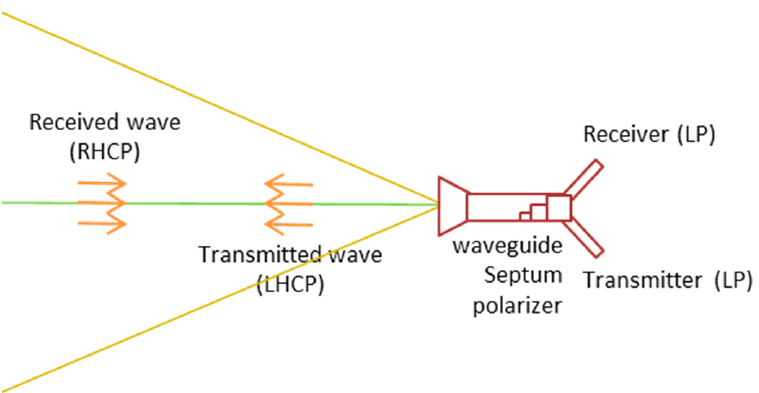
Figure 9. Feed systems using waveguide circular polarizers and OMTs instead of LP filters and TMCPs or RMCPs.